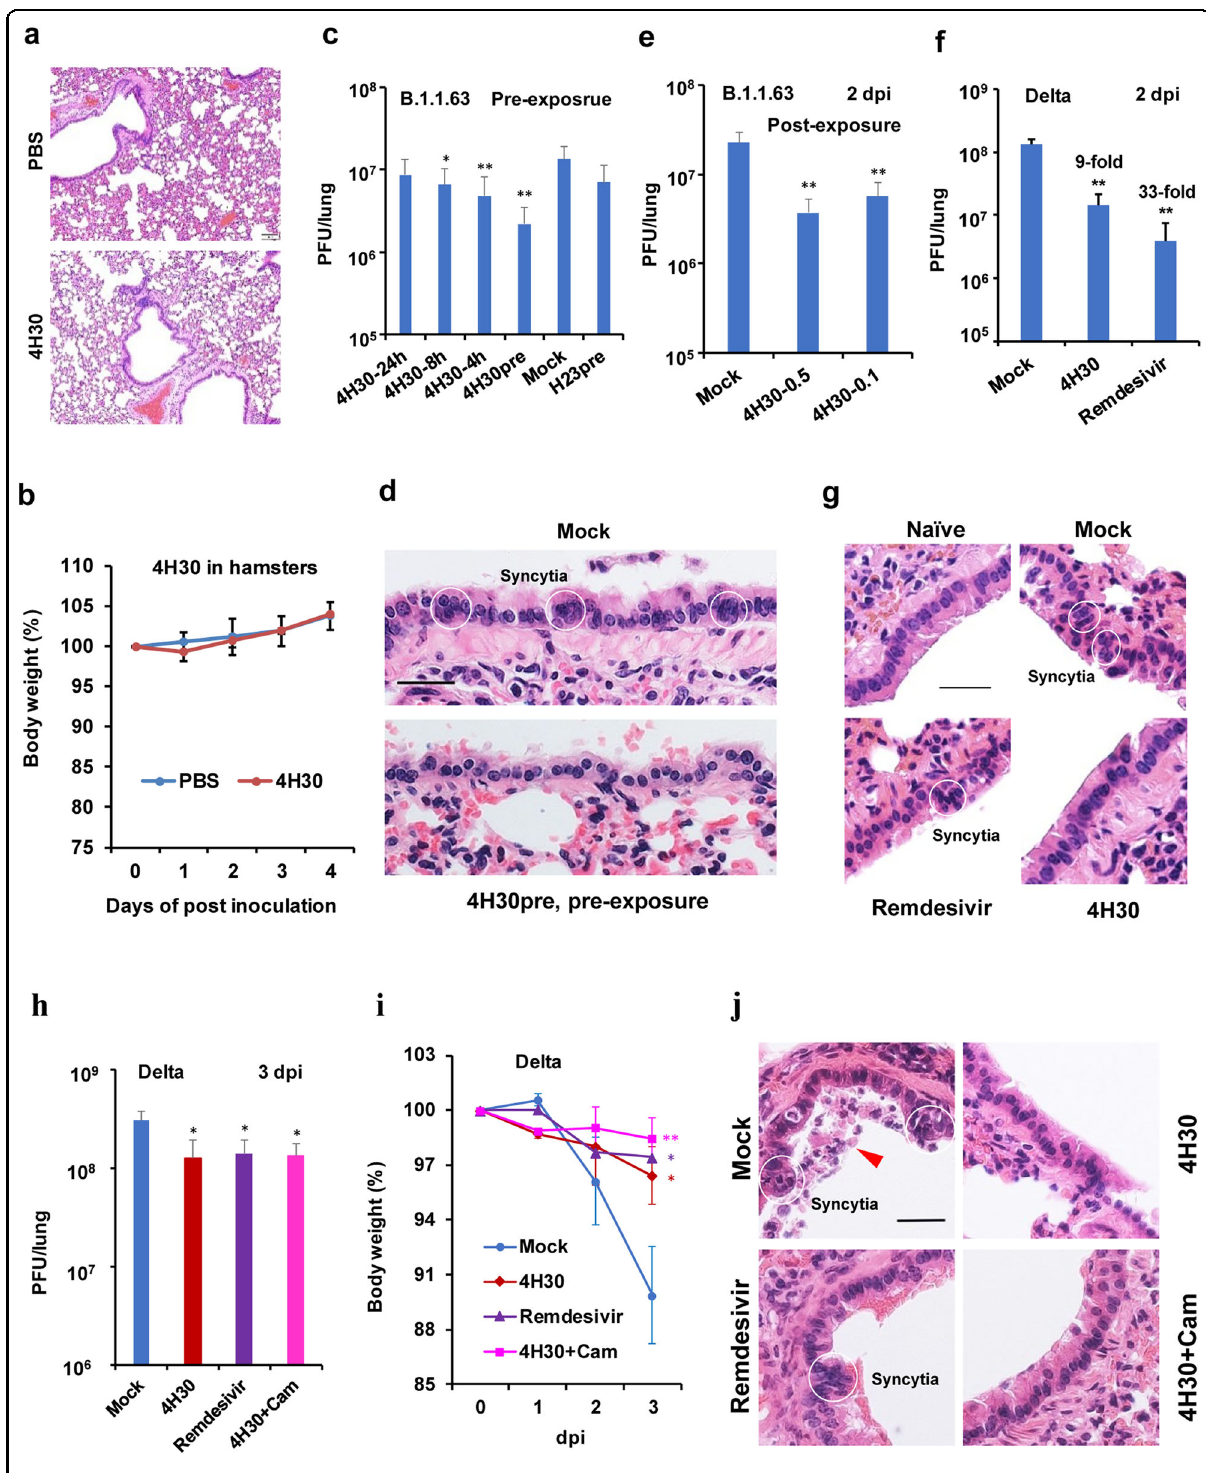
Fig. 4 (See legend on next